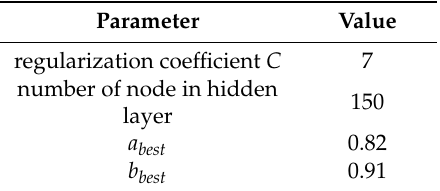
Table 3. Main parameters of the BFO-IELM model.